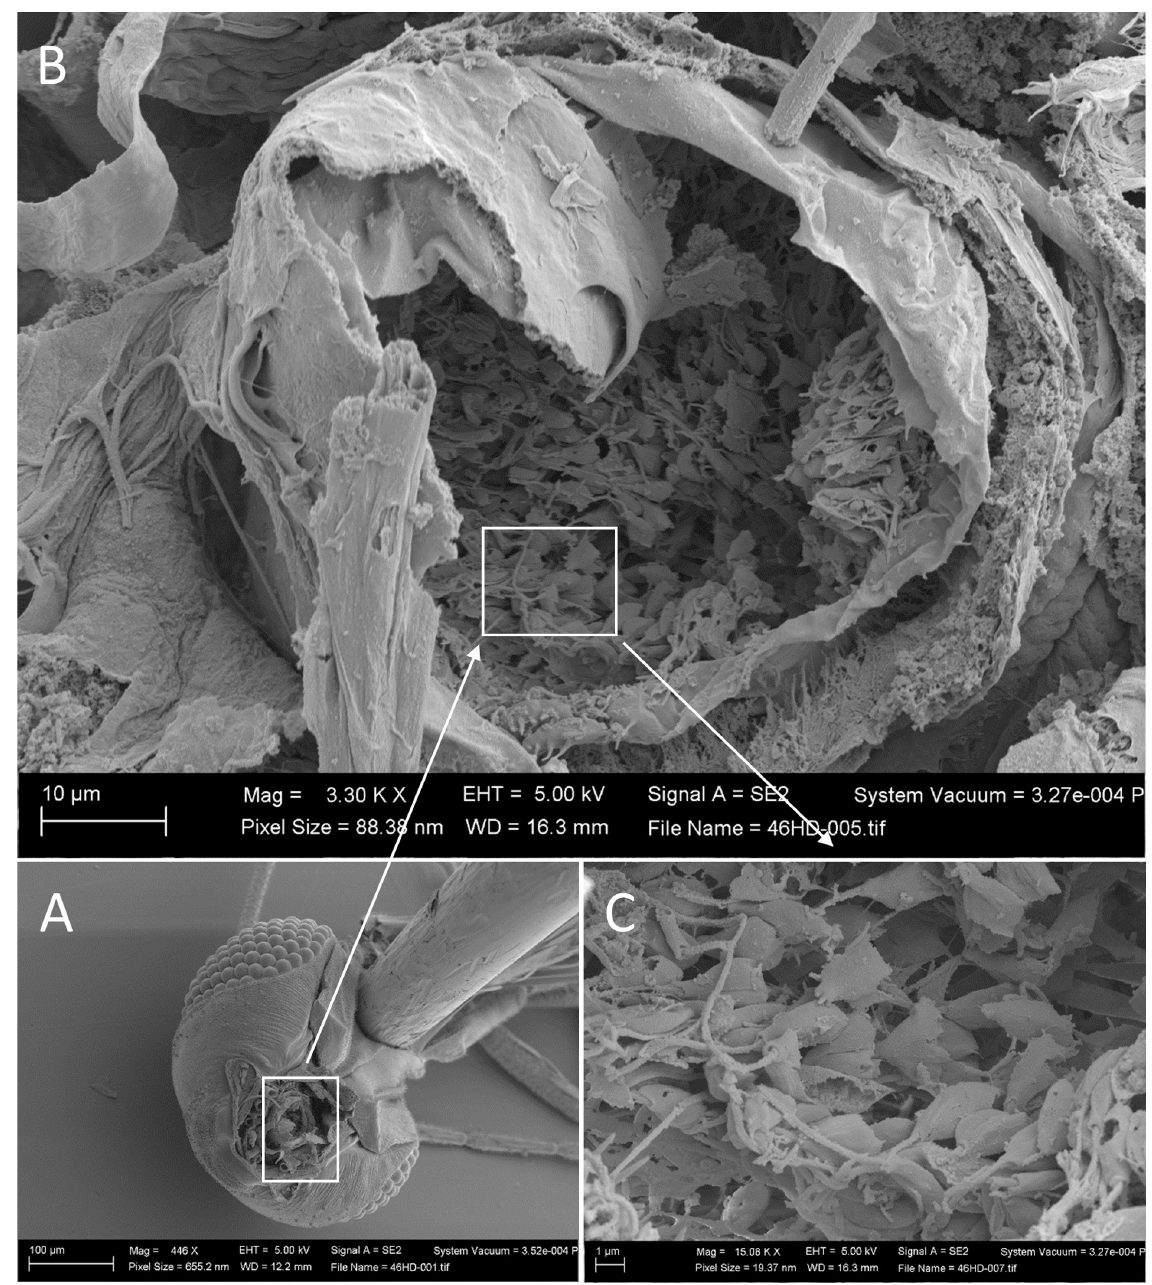
Fig 6. Scanning electron micrographs of the posterior surface of the dissected head of a sand fly nine days after an infective blood meal and four days after a second uninfected blood meal, T9INF+. A) pinned head showing orientation on SEM stub enabling view into pharynx; B) view into the dissected pharynx showing large numbers of Leishmania mexicana parasites; C) close-up of L . mexicana parasites.